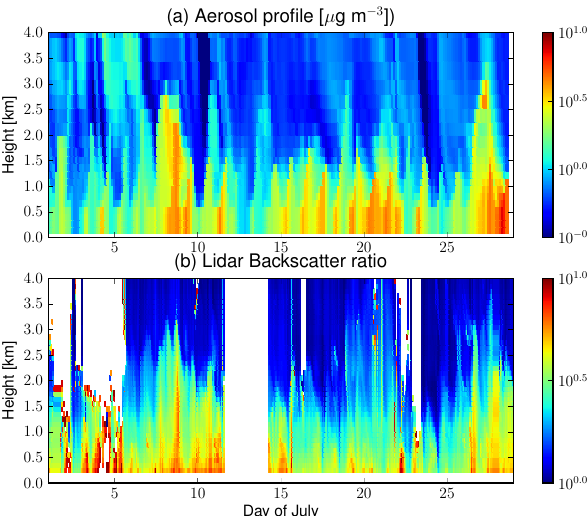
Fig. 3. (a) The simulated aerosol vertical profile (sulfates + organics) for the 0.5 ◦ × 0.667 ◦ resolution, and (b) the measured LIDAR backscatter ratio at Whistler. The time is UTC. White spaces in the Lidar data are the result of clouds, which are masked as they result in a backscatter ratio much greater than that of aerosols. Between approximately the 12 and 14 July, the Lidar was not functioning (also